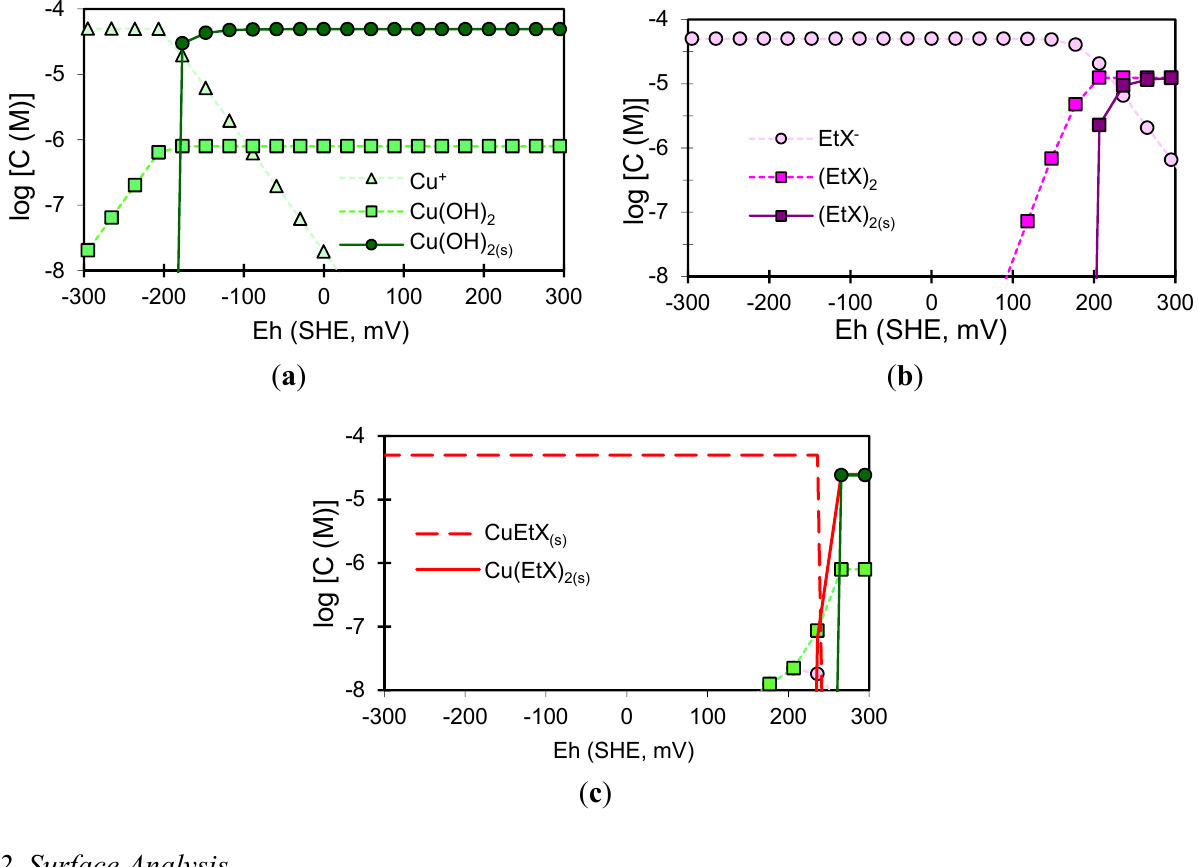
Figure 6. Solution speciation simulations of ( a ) 10 − 5 M Cu 2+ ; ( b ) 10 − 5 M ethylxanthate, and ( c ) 10 − 5 M Cu 2+ and elthylyxanthate, all as a function of E is simplified to only include species not already defined in ( a ) and ( b